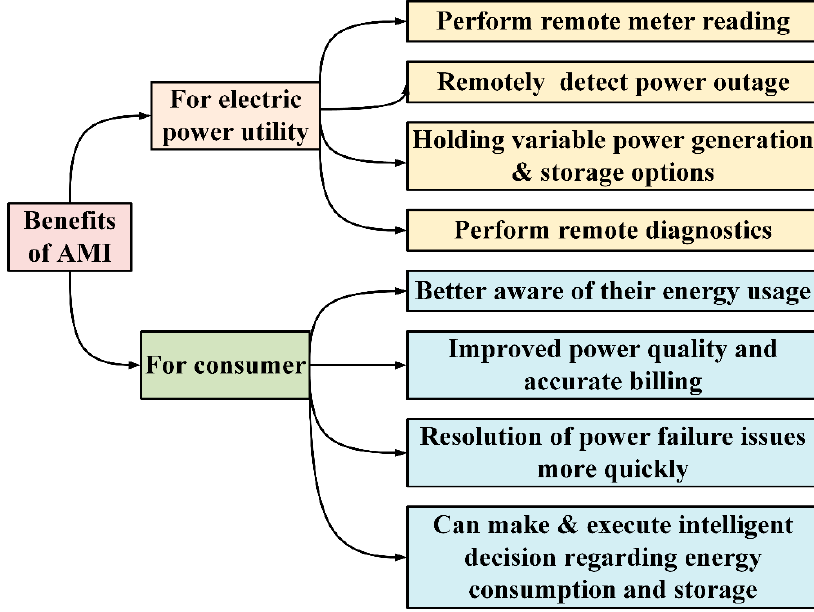
Figure 2. Advantages and features of AMI [37].